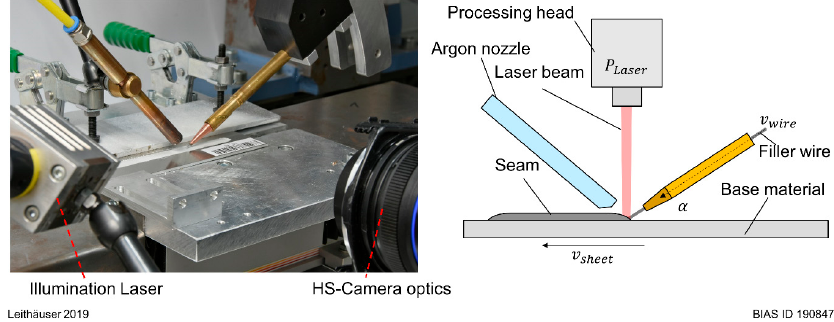
Figure 2. Test setting for the bead-on-plate brazes with high-speed camera observation.